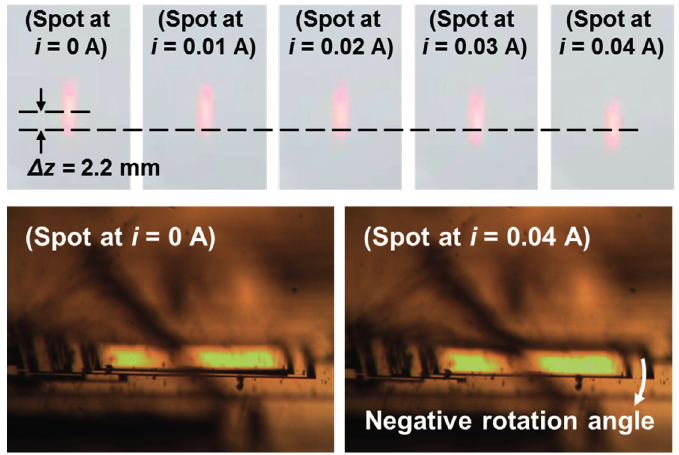
Figure 9. Trace of the light spot on a screen of the reflected laser beam from the restricted-torsion-type mirror. In addition, the mirror postures at i = 0 A and 0.04 A are